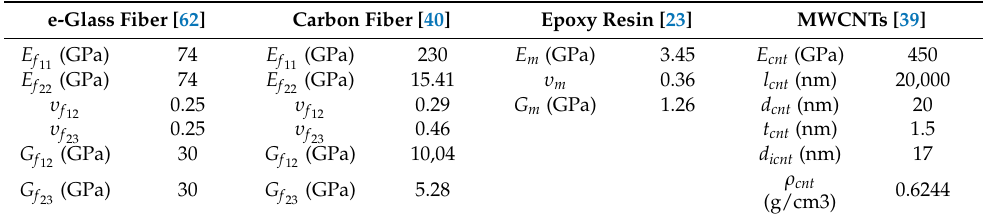
Table 1. Materials properties of the components.